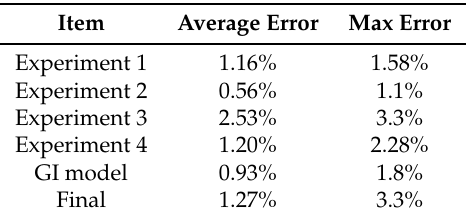
Table 2. Experimental error results.